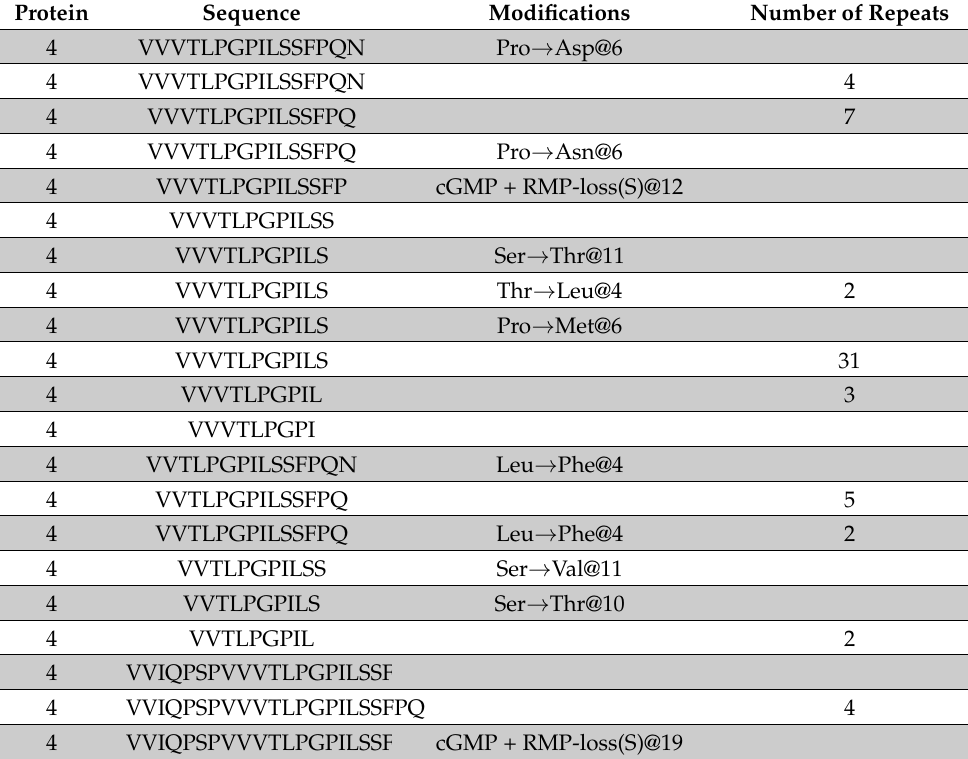
Table 4. Peptide sequence of the chicken feather microbial degradation present in the fraction P188D 40% with 99% of confidence and its homology to Keratin Chicken Feather 4 and